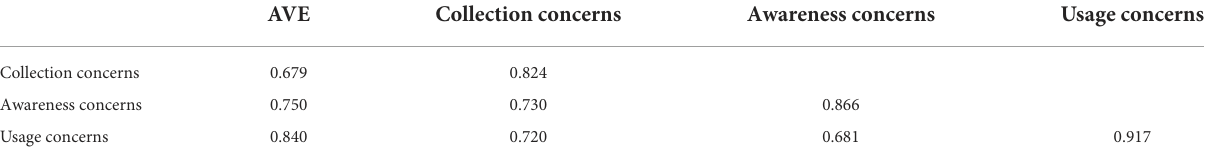
TABLE 9 Discriminant validity ( n = 296).